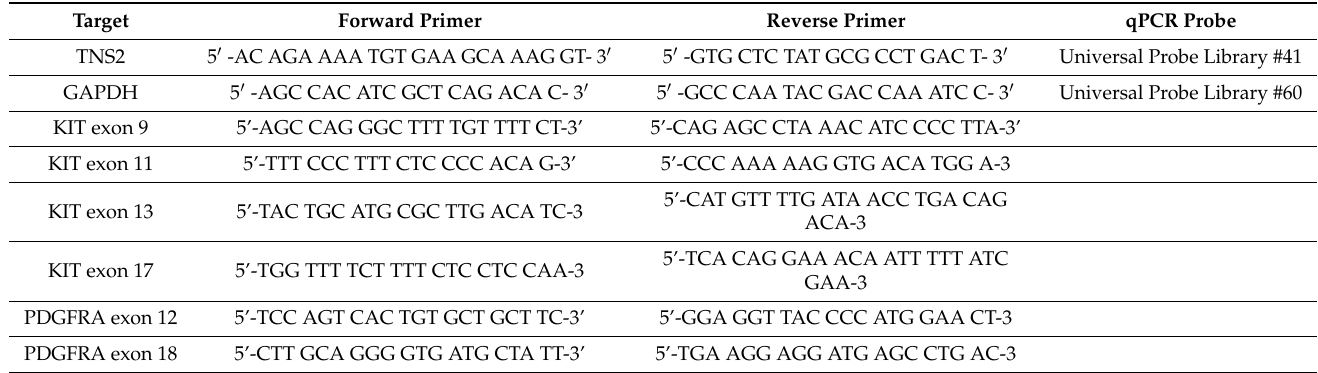
Table 1. Primers and probes used in PCR and quantitative